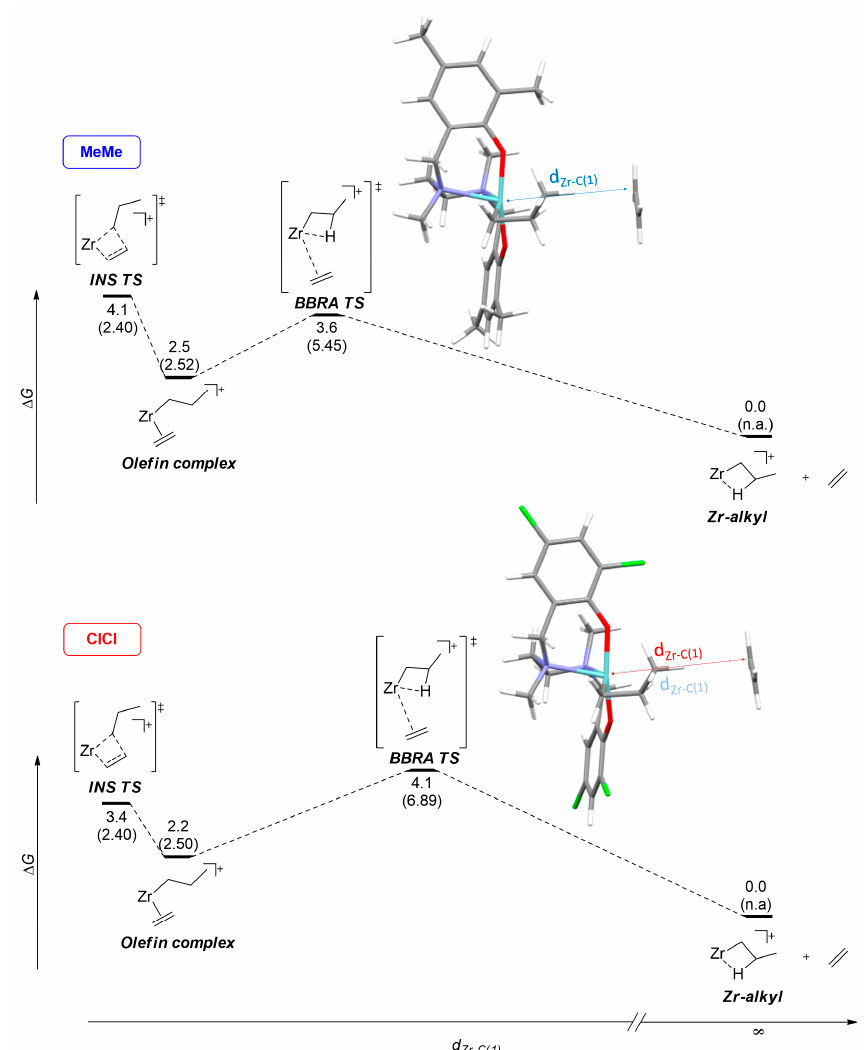
Figure 4. Energy profiles for ethene homopolymerization predicted by DFT for MeMe and ClCl . INS = insertion, BBRA = backbone rearrangement. Relative Gibbs free energy differences in kcal/mol; numbers in brackets: distances between the Zr and C(1) carbon of ethene in Å ( d Zr-C(1) ). n Pr group used as model for the polymeryl chain after ethene insertion (see Materials and